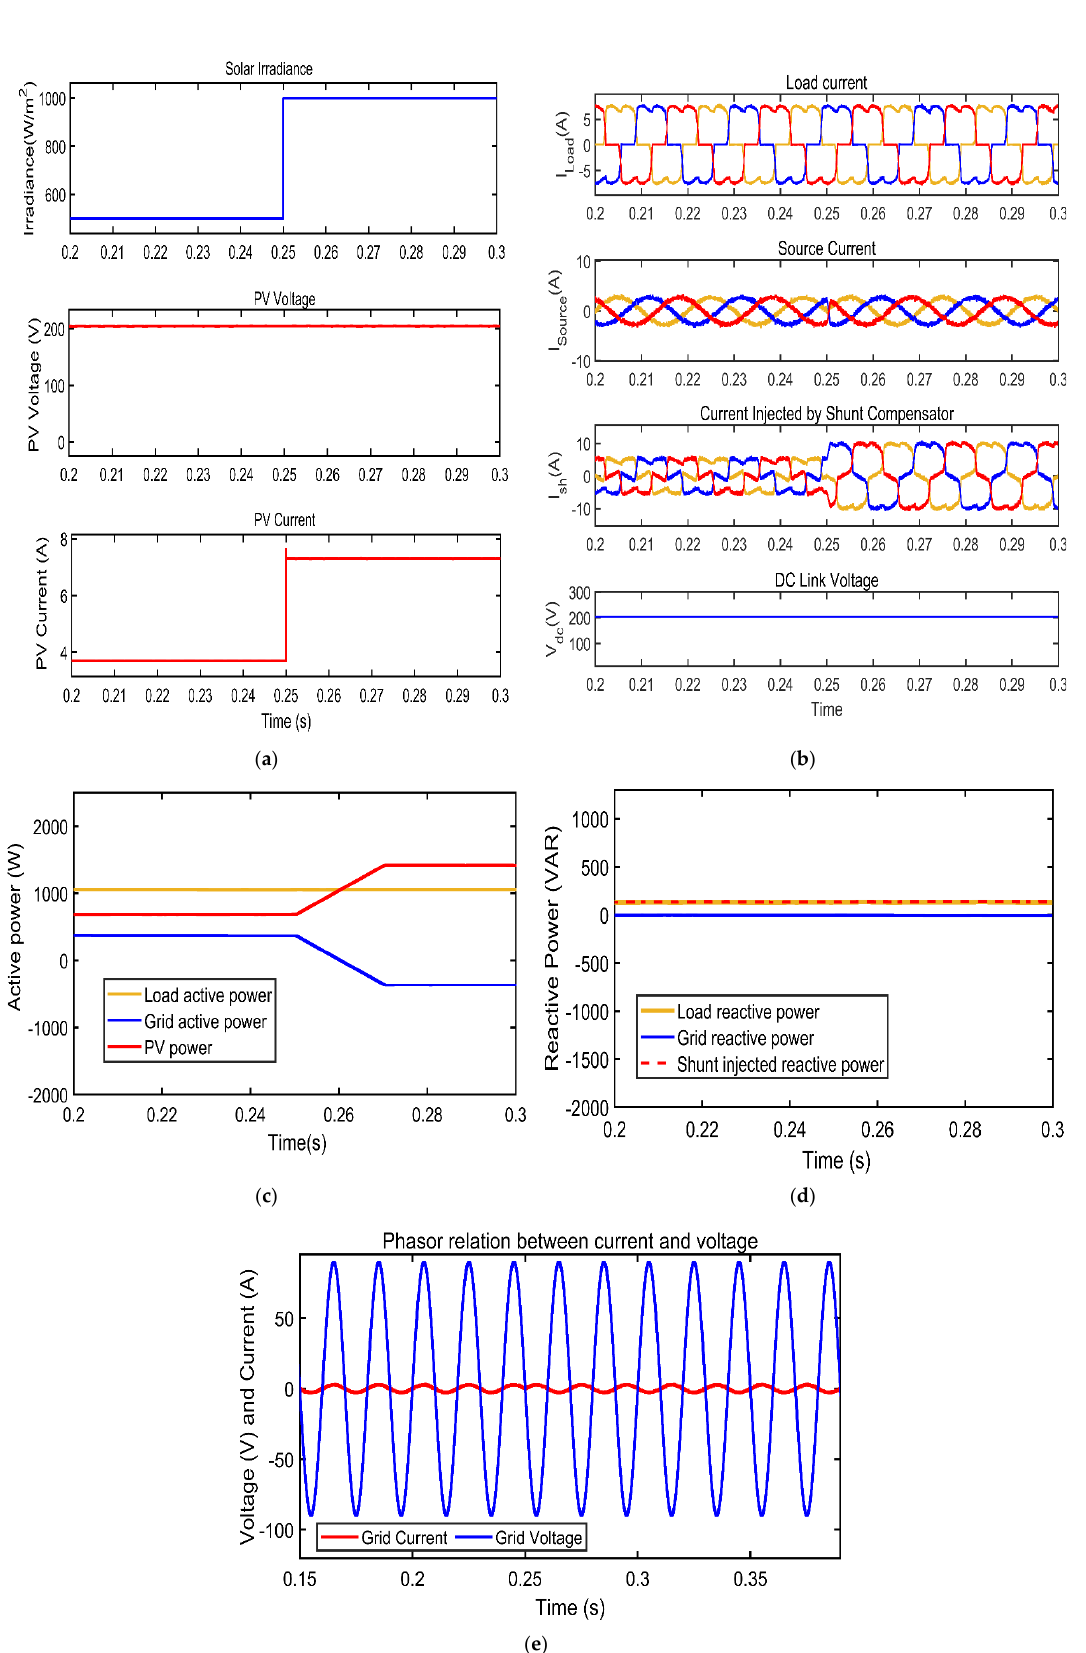
Figure 5. Under varying solar irradiance from 500 W/m 2 to 100 W/m 2 : ( a ) PV voltage and current; ( b ) performance of PV–DSTATCOM; ( c ) real power balance between PV, grid and load; ( d ) reactive power balance between PV, grid and load; ( e ) phase relation between voltage and current.